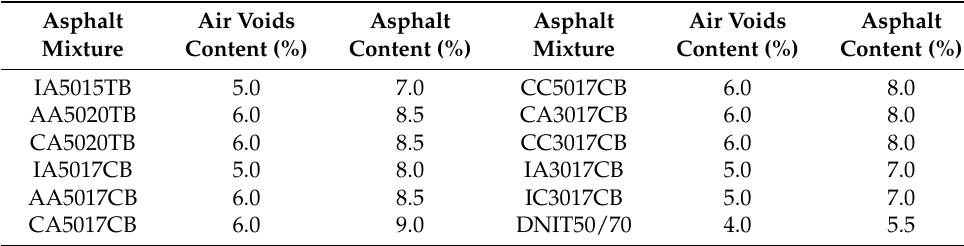
Table 8. Volumetric parameters of asphalt rubber mixtures.